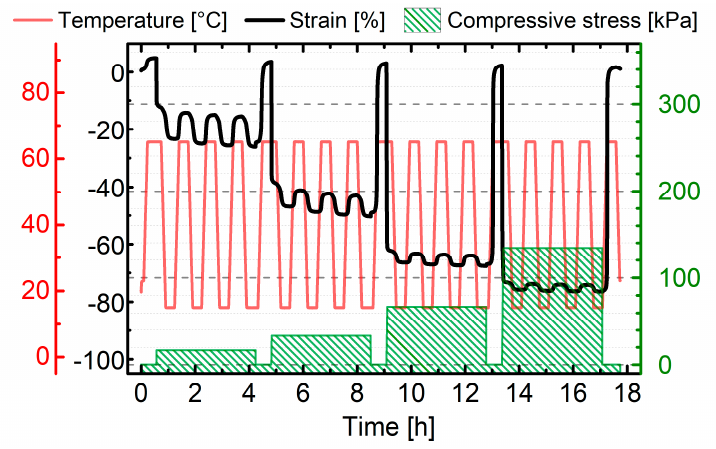
Figure 9. Thermomechanical protocol investigating the influence of compressive stress upon the actuation of the PEUU foam.